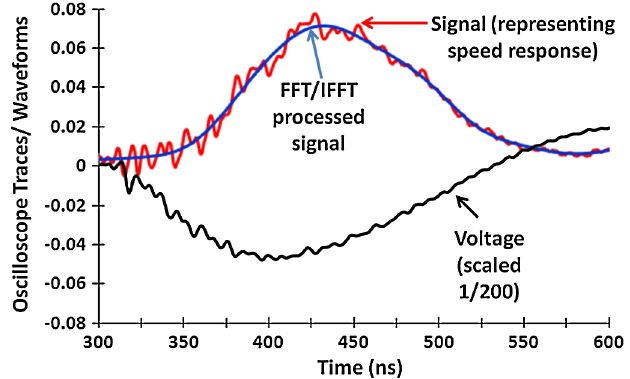
FIG. 11. Time response of phase shifter. Convex curve with wiggles (red) is the signal which is the difference between data with rf off and rf on. Smooth convex curve (blue) is the result of FFT/IFFT processing. The concave black curve is the high- voltage pulse with its peak value of (cid:1) 9 : 7 kV . It is seen that the time delay between the peak voltage and the peak variation in phase is 28 ns. This value excludes delays in cables. The difference signal of 67 mV from the mixer corresponds to a phase change of 77 (cid:7) . (One horizontal division is 50 ns.)